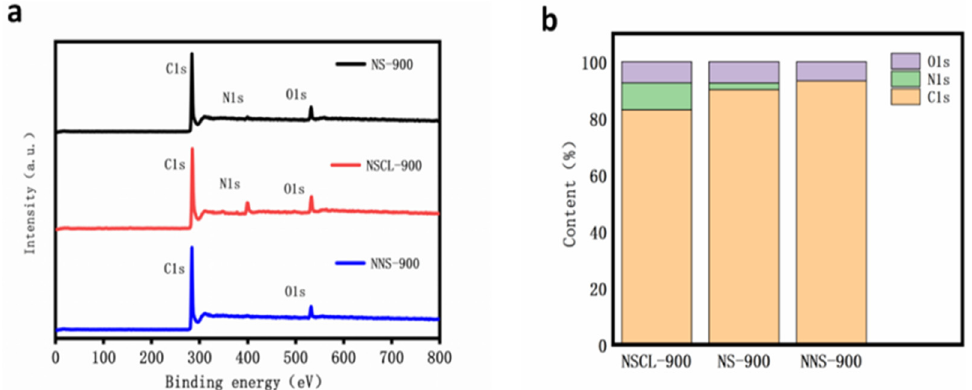
Figure 3. XPS spectrograms of NS-900, NSCL-900, and NNS-900: ( a ) illustration of content of various elements in NSCL-900, NS-900, and NNS-900 ( b ).